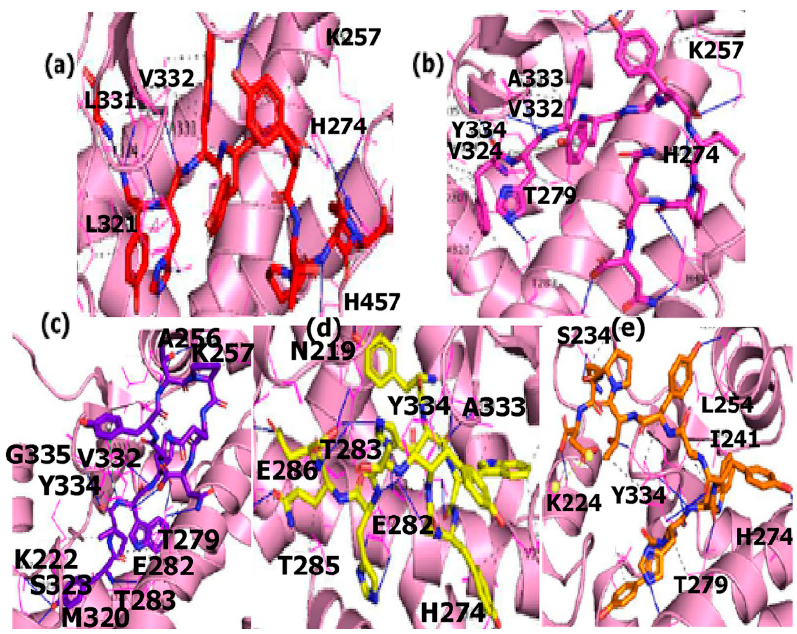
Figure 4. PLIP results for each of the peptides bound to PPAR α receptor. ( a ) Original peptide; ( b ) Mut1 ( c ) Mut2 ( d ) Mut3 ( e ) Mut4. For Mut1 (Figure 4b and Supplementary Information Table S4b), thirteen hydrophobic interactions, twelve H-bonds, and a π -stacking interaction with Tyr334A were observed. New hydrophobic interactions were observed with Thr283A, Met320A, and Val324A, while new H-bonds occurred with Leu254A, Thr283A, and Thr285A. For Mut2, extensive hydro- gen bonding (fourteen) and hydrophobic interactions (eleven) were observed compared with Pep, and a π -stacking interaction with Tyr334A was again observed, as shown in Figure 4c and Supplementary Information Table S4c. New hydrogen bonds occurred with Tyr214A, Lys222A, Leu254A, and Ser323A, while new hydrophobic interactions were seen with Glu282A, and Met320A. Mut3 (Figure 4d and Supplementary Information Table S4d) exhibited thirteen hydrophobic interactions and sixteen H-bonds. New hydrophobic inter- actions occurred with Val255A, Thr283A, Thr285A, Glu286A, Glu289A, and Val324A, while new H-bonds occurred with Asn217A, Asn219A, Met220A, Glu282A, Thr283A, Glu286A, and Glu289A. Mut4 (Figure 4e and Supplementary Information Table S4e), displayed ten hydrophobic interactions and ten hydrogen bonds. New hydrophobic interactions were observed with Lys224A, Asn236A, Leu254A, and Val324A and new H-bonds were seen with Lys224A, Ser234A, Thr253A, and Thr283A. A salt bridge was formed with Lys224A. PLIP interactions of the peptide-polyphenol conjugates and PPAR α were next ex- amined as shown in Figure 5 and Supplementary Information Table S5. The CGAPep conjugate displayed seventeen H-bonds and fourteen hydrophobic interactions as well as two π -stacking interactions (Figure 5a and Supplementary Information Table S5a). New hydrogen bonds formed included those with Lys216A, Asn219A, Leu254A, Cys278A, Thr279A, Glu282A, Thr285A, and Glu696B, while new hydrophobic interactions were seen with Val255A, Leu258A, Glu282A, Ile339A, and Leu693B compared to Pep. As seen in Figure 5b and Supplementary information Table S5b, eight hydrogen bonds and nine hydrophobic interactions were observed for CSAPep, while a π -stacking interaction oc- curred with Tyr334A of PPAR- α . Hydrogen bonds were still observed with Thr279A and Tyr334A, while all others were seen with new residues, including Lys224A, Glu282A, and Asn336A. All hydrophobic interactions, except for two with Tyr334A, were formed with new residues, including Val255A, Val281A, Glu282A, Thr285A, Glu286A, and Glu289A. The GLAPep conjugate displayed fourteen hydrogen bonds and thirteen hydrophobic interactions, as seen in Figure 5c and Supplementary Information Table S5c. New